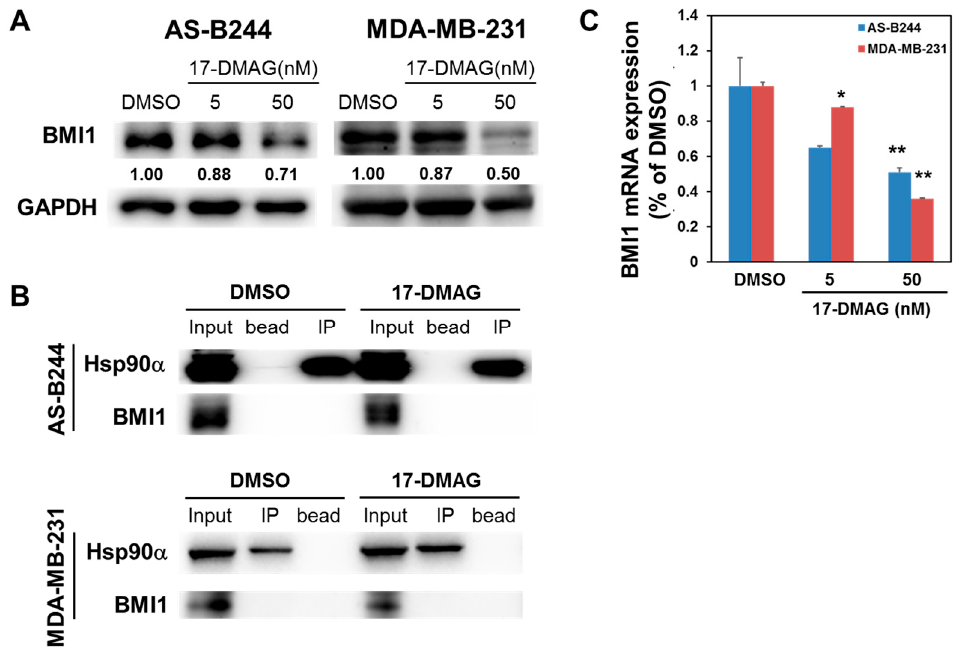
Figure 2. 17-DMAG down-regulated B lymphoma Mo-MLV insertion region 1 homolog (BMI1) expression in TNBC mammospheres at mRNA and protein level and BMI1 was not interacted with Hsp90 α . AS-B244 or MDA-MB-231 TNBC cells were performed mammosphere cultivation for 48 h and then treated with 0.1% DMSO or indicated concentration of 17-DMAG. The proteins were extracted at 96 h after treatment and used for determination of BMI1 protein expression with Western blot ( A ). Inserted numbers in ( A ) presented the relative expression level when compared to DMSO control. The binding of BMI1 and Hsp90 α under 50nM 17-DMAG treatment was determined by immunoprecipitation with anti-Hsp90 α antibody ( B ). The total RNA were isolated at 48 h after treatment and BMI1 mRNA expression was measured by SYBR Green-based qRT-PCR ( C ). * p < 0.05; ** p < 0.01.